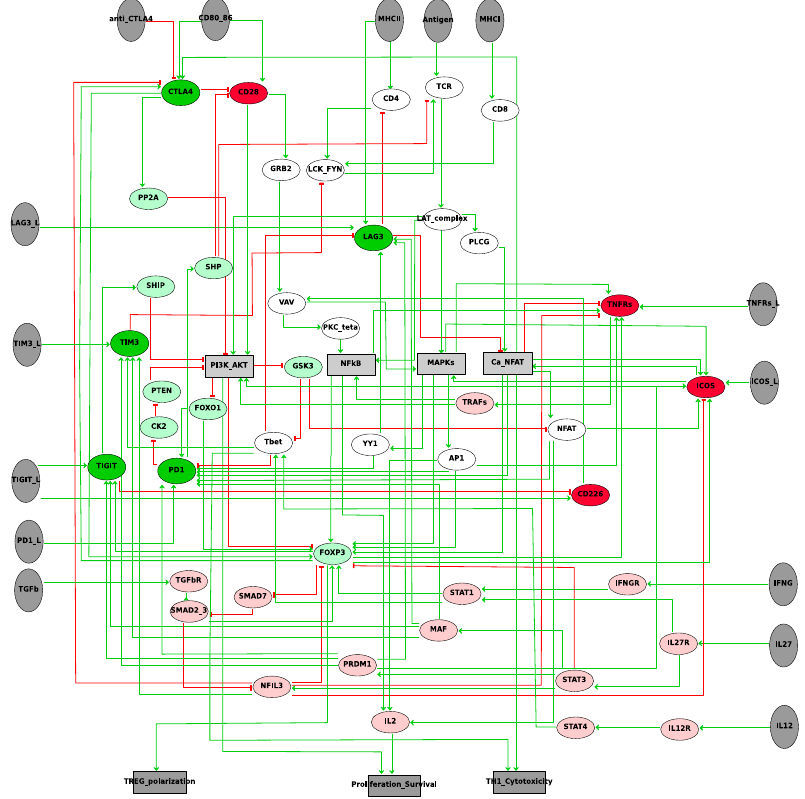
Figure 2. Influence network of TCR signalling. The antigen recognition by TCR leads to the formation and activation of LAT (linker of activated T cells) protein complexes, including, among other proteins, VAV and phospholipase C gamma (PLCG). LCK / FYN (p56lck / p59fyn) kinases also participate in this process via phosphorylations of key molecules of TCR complexes. This LAT-signalosome initiates several downstream signalling pathways such as Ca 2 + / nuclear factor of activated T-cells (NFAT), mitogen-activated protein kinases (MAPKs) (p38, c-Jun N-terminal kinase (JNK), and extracellular-signal-regulated kinase (ERK), and nuclear factor kappa-light-chain-enhancer of activatedBcells(NFkB)[27]. Thesepathwaysactingtogetherinducetheexpressionofinterleukin-2(IL2), which is a key regulator of T cell proliferation and clonal expansion. Another signalling pathway needed for a complete T cell activation is the phosphoinositide 3-kinase (PI3K) / AKT pathway, which reinforces the survival of activated T cells. Ligands for inhibiting and activating checkpoints as well as cytokines modulate the activity of the TCR signalling network on di ff erent levels. Key players of TCR signalling (white nodes) with activating (red nodes), inhibiting (green) checkpoints, and interactions with cytokines (pink nodes) are recapitulated into an influence network: nodes (ellipses) represent ligands (dark grey), proteins, genes or pathways, and edges account for positive (in green) or negative (in red) influence of one entity onto the others; square nodes show pathways (light grey) or phenotypes (dark